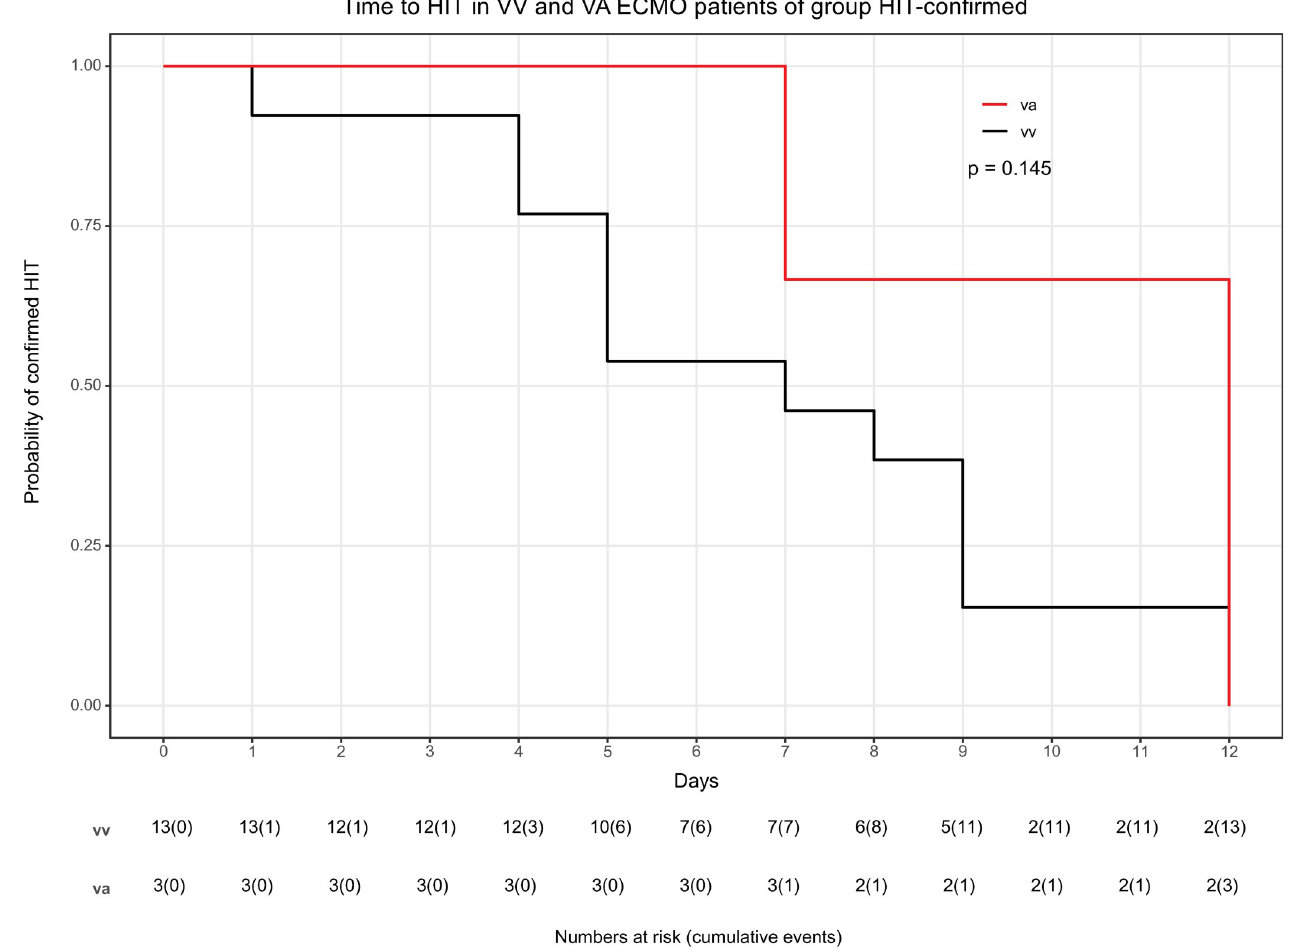
Fig 2. Confirmed HIT probability during ECMO therapy according to VV and VA ECMO. Kaplan-Meier plot of HIT probability during ECMO therapy according to VV ECMO and VA ECMO of group HIT-comfirmed. X-axis: Time to HIT = Time between ECMO initiation and switch to alternative anticoagulation (argatroban). Y-axis: Probability of confirmed HIT diagnosis